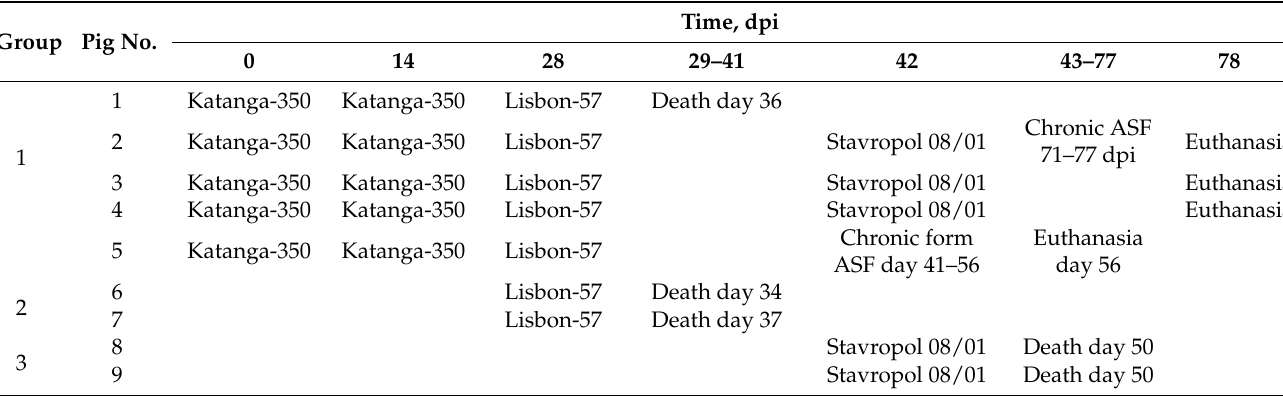
Table 2. Design of the experiment and consequences of inoculation by Katana-350 followed by challenging with Lisbon-57 and Stavropol 08/01